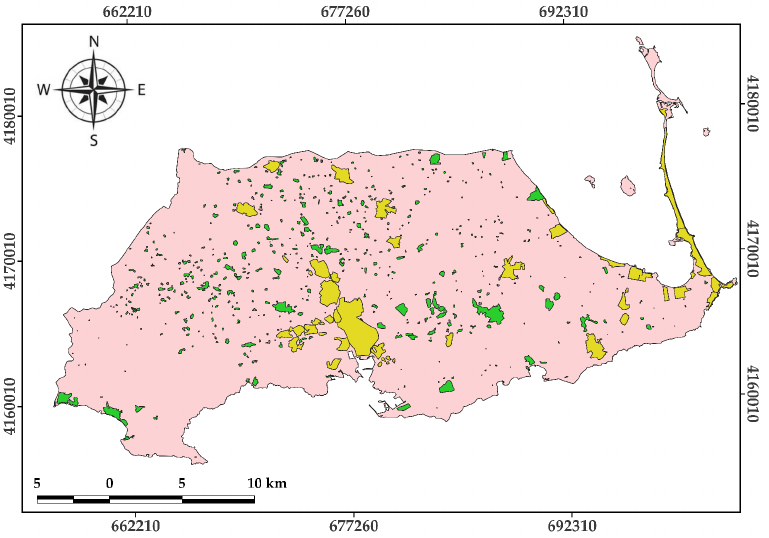
Figure 4. Differentiation of the population centers for which community ( ) and centralized ( ) composting with collection is proposed (own elaboration).